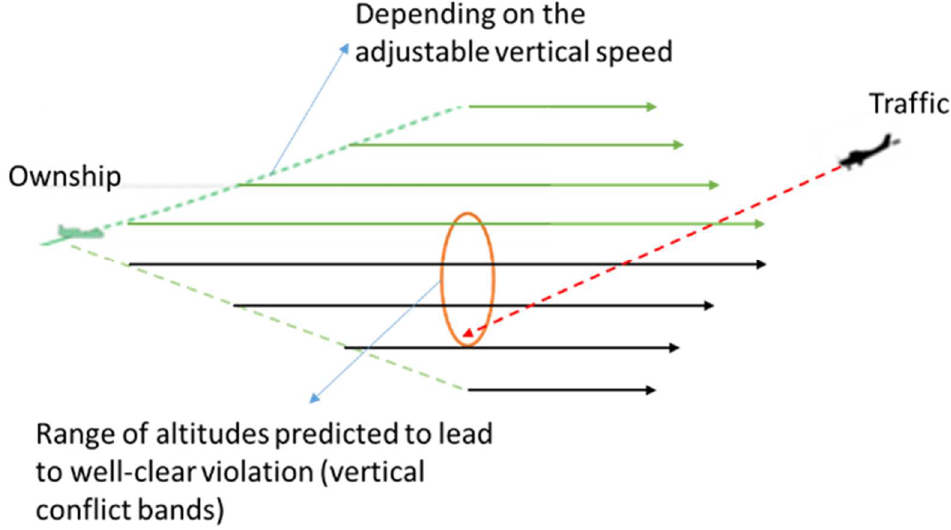
Figure 10. Aircraft state projection for the computation of the vertical conflict bands.